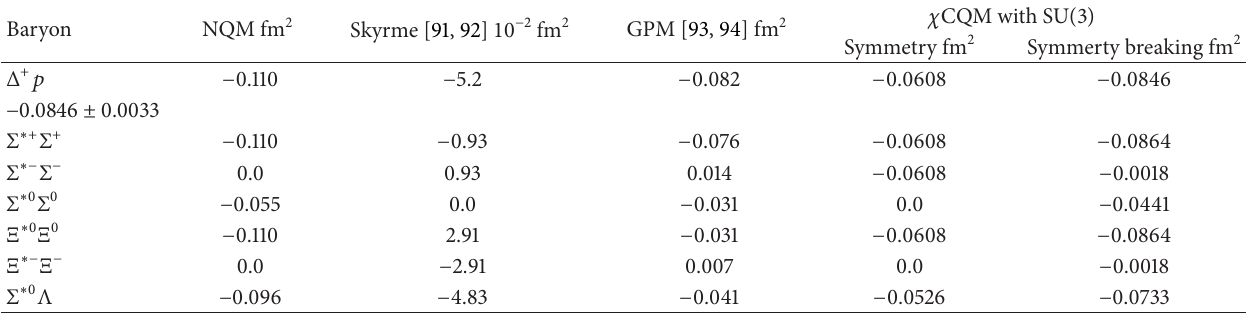
Table 11: Quadrupole moments of the spin (3/2) + → (1/2) + decuplet to octet transitions in 𝜒 CQM using GPM and SU (3) symmetry breaking. Baryon NQM fm 2 Skyrme [91, 92] 10 −2 fm 2